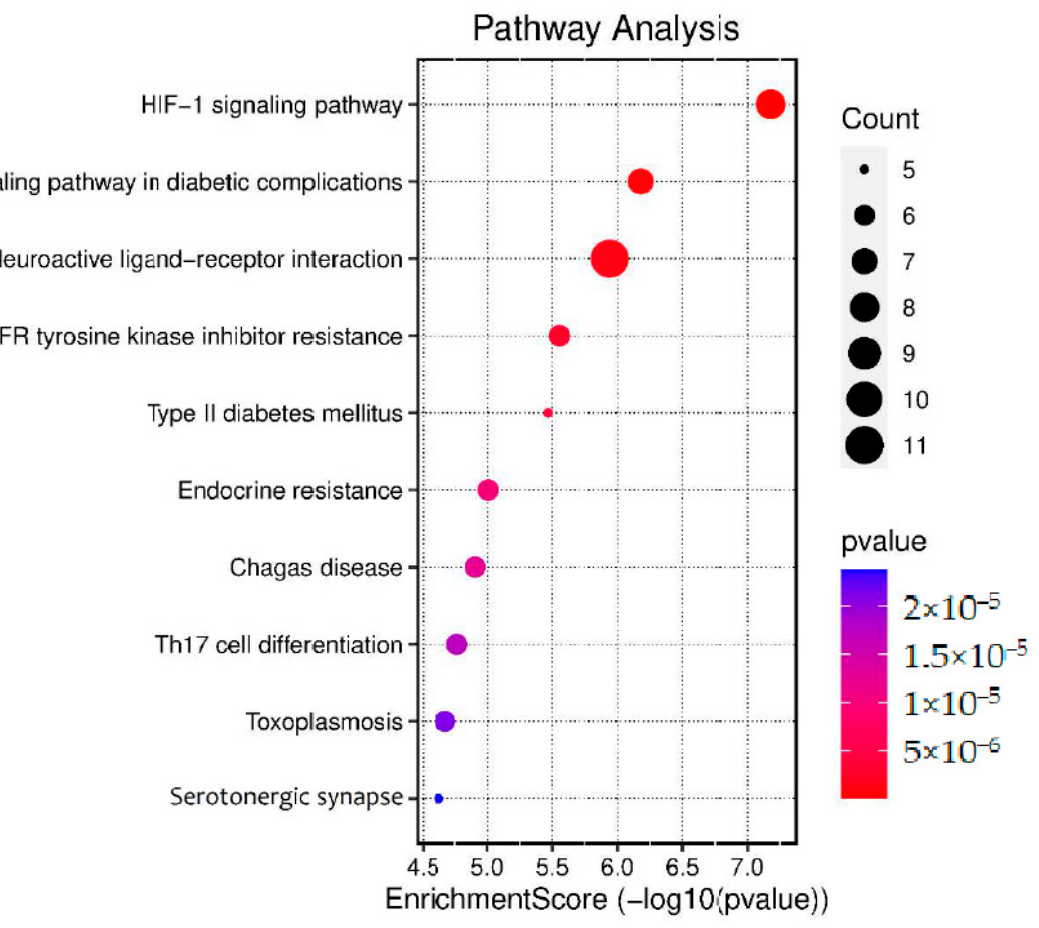
Figure 5. KEGG pathway analysis.